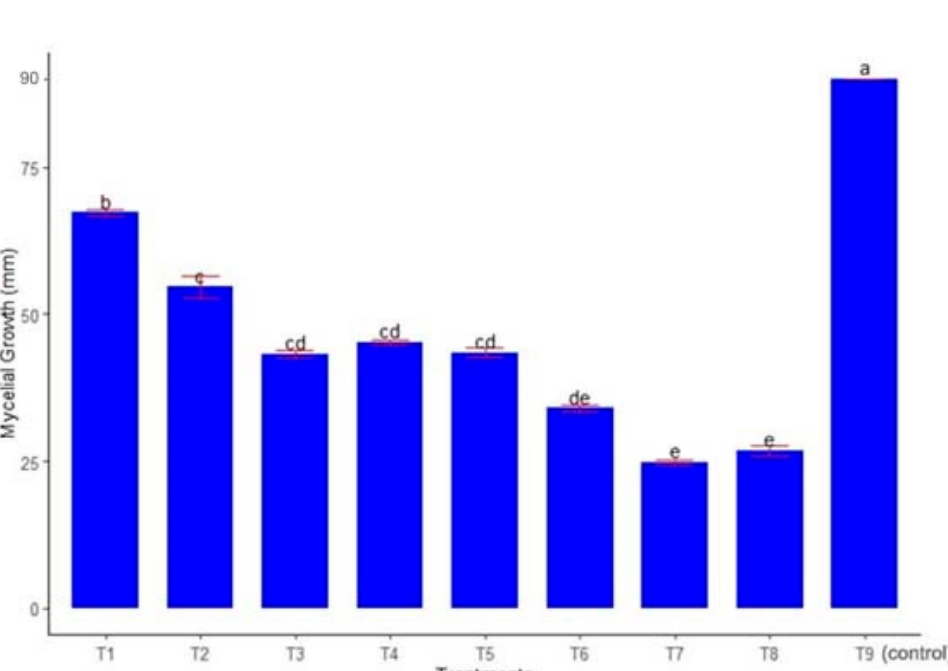
Figure 1. Mycelial growth rate (mm) of Fusarium oxysporum treated with biocontrol agents and chemical. Bars represent mean ( ± standard error) of mycelial growth rate (mm) of Fusarium oxysporum treated with T 1 = Bacillus stratosphericus ; T 2 = Bacillus pumilus ; T 3 = Bacillus subtilis ; T 4 = Pseudomonas aeruginosa ; T 5 = Pseudomonas putida ; T 6 = Pseudomonas fluorescens ; T 7 = Trichoderma asperellum ; T 8 = carbendazim, and T 9 = control (only Fusarium oxysporum ). * Means followed by the same letter do not significantly differ (p < 0.05) with DNMRT .